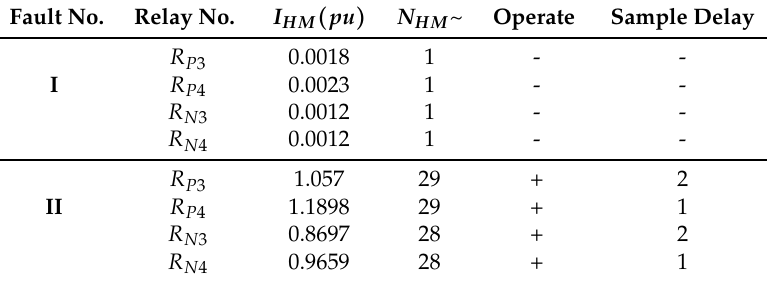
Table 4. Performance of the FCFH protection scheme for case 1.